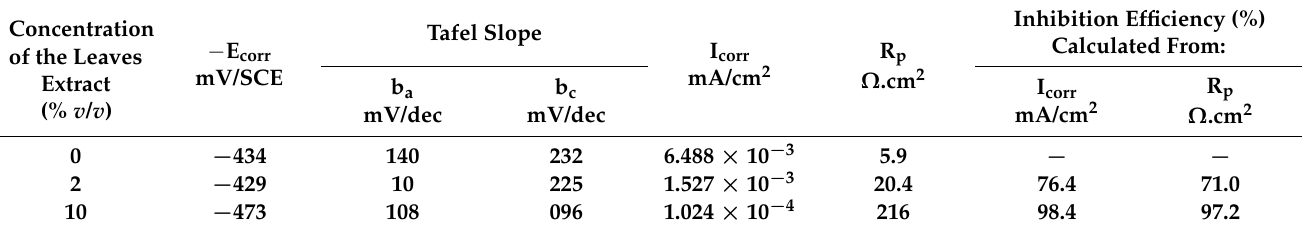
Table 10. Potentiodynamic polarization parameters for the corrosion of mild steel in 1.0 M HCl without and with various concentrations of SA leaf aqueous